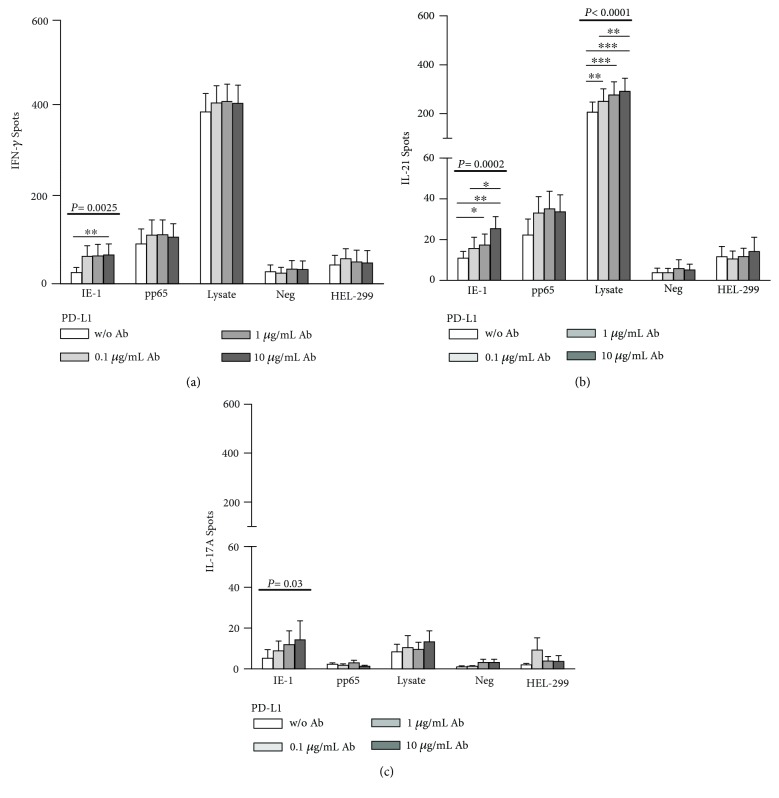
Increase of CMV-specific cytokine secretion by PD-L1 antibodies. The figure shows the IFN-γ (a), IL-21 (b), and IL-17A (c) production without and with the addition of PD-L1 antibodies. Lymphocytes of 26 kidney transplant patients, stimulated with CMV IE-1, pp65, CMV lysate (lysate), and HEL-299 lysate, were incubated with the antibody at concentrations of 0.1, 1, and 10 μg/ml. Unstimulated cells (neg) served as a negative control for stimulation with IE-1 and pp65, and the HEL-299 lysate as a negative control for the CMV lysate. IFN-γ secretion was determined in 12-18 patients, IL-21 in 13-15 and IL-17A in five patients. Mean and standard of the mean (SEM) of spot numbers are depicted. The effect of PD-L1 antibodies was analyzed by one-way ANOVA with a posthoc test. Values above the bold horizontal lines indicate significant P values obtained by the Friedman test, significant results of Dunn's posthoc test (to compare the various concentrations) are given above the thin horizontal lines (∗
P < 0.05, ∗∗
P < 0.01, and ∗∗∗
P < 0.001).